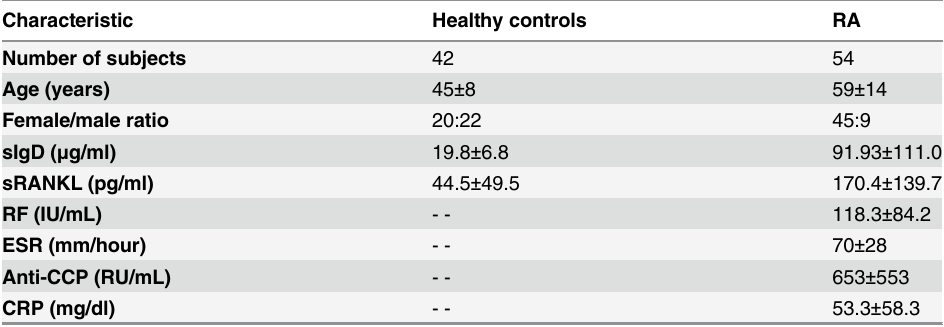
Data are means ± standard deviation. Anti-CCP = anti-cyclic citrullinated peptide; CRP = C-reactive protein; ESR = erythrocyte sedimentation rate; RA = rheumatoid arthritis; RF = rheumatoid factor; sRANKL = soluble receptor activator of nuclear factor- κ B